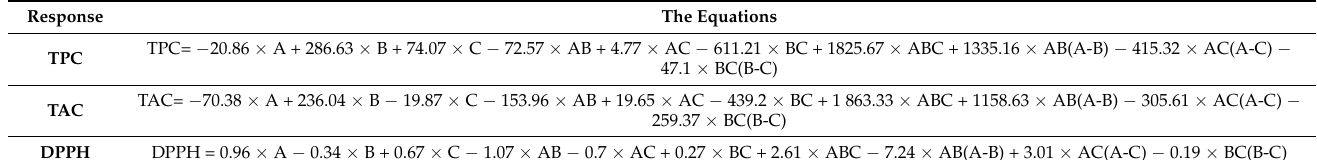
Table 3. The equation of the three models TPC, TAC, and DPPH in terms of the real components. Response The